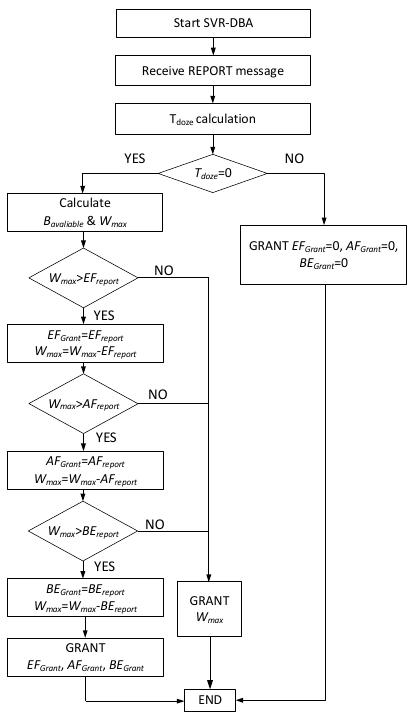
Figure 4. Bandwidth allocation of SVR-DBA.